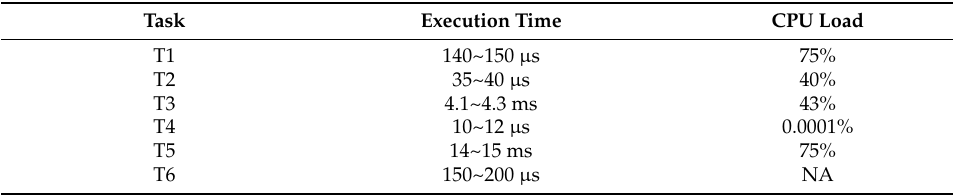
Table 4. Average task execution time and CPU load.